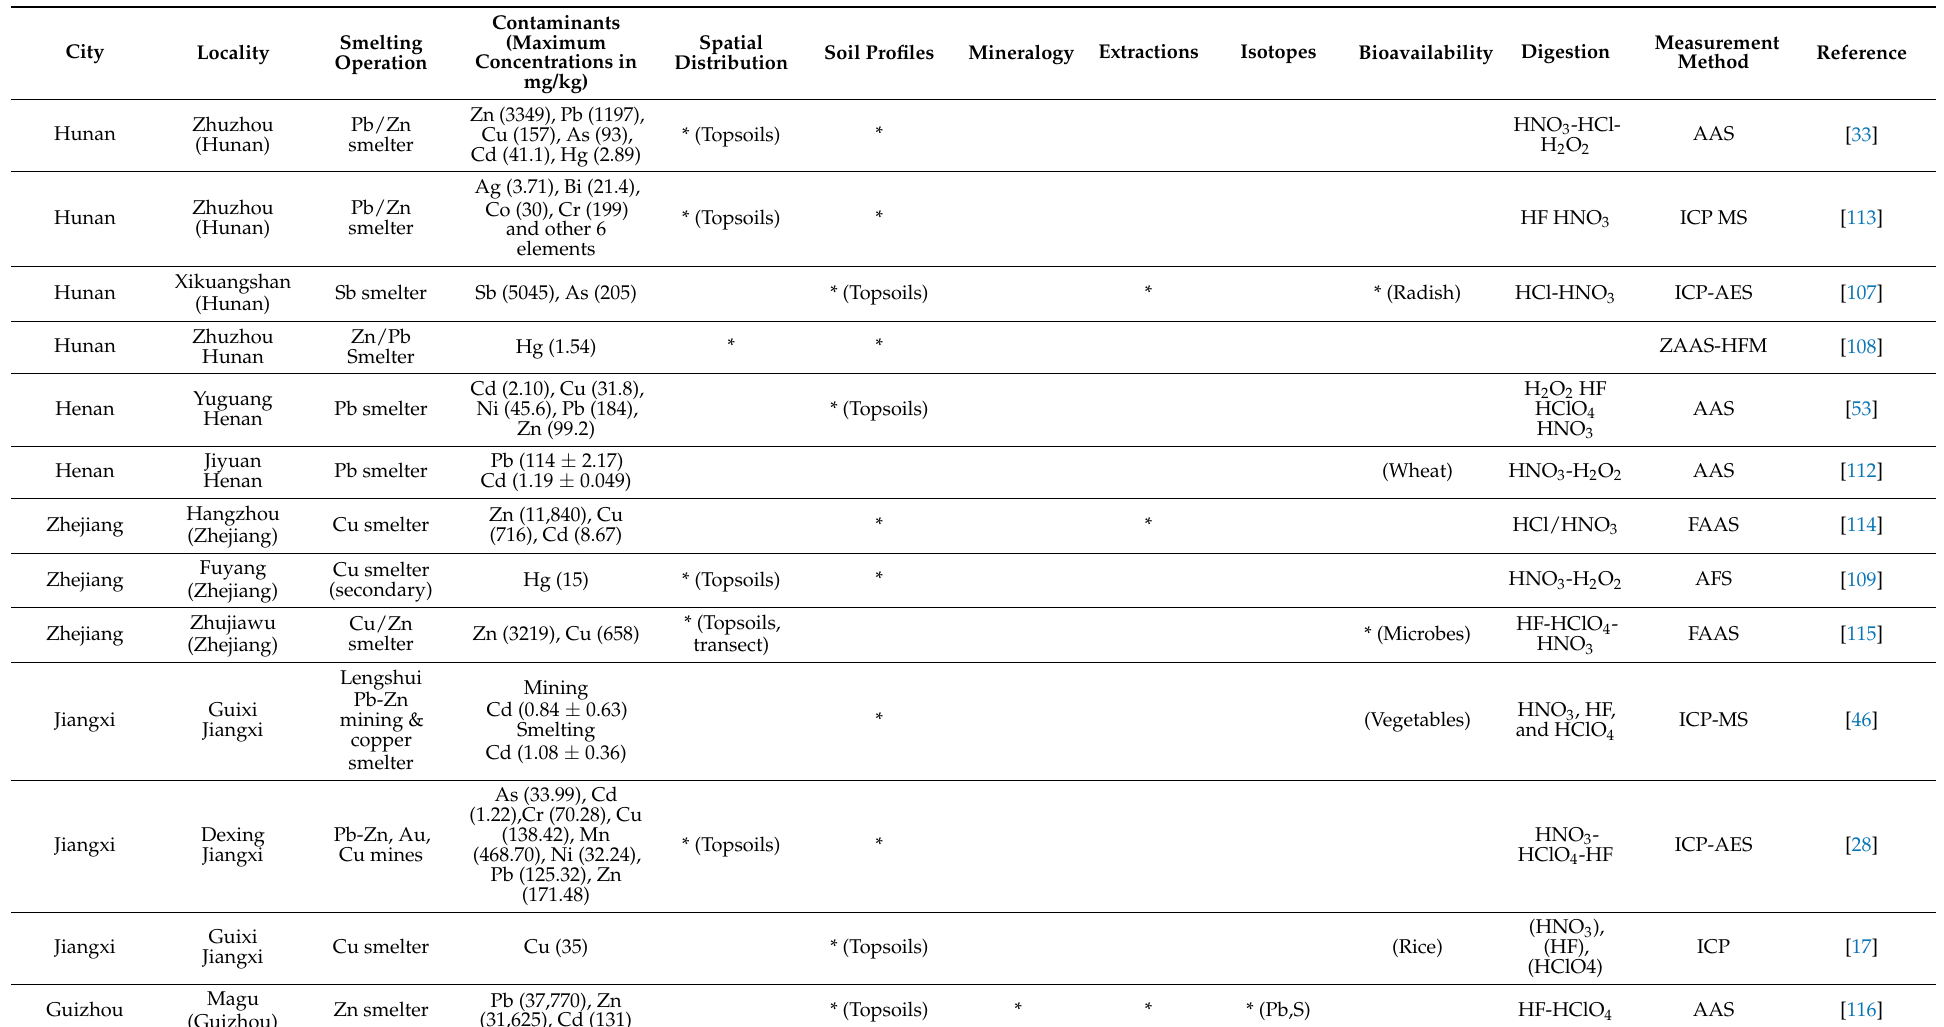
Table 3. Descriptions of studies dedicated to soils around smelteries in China. * This data is “not